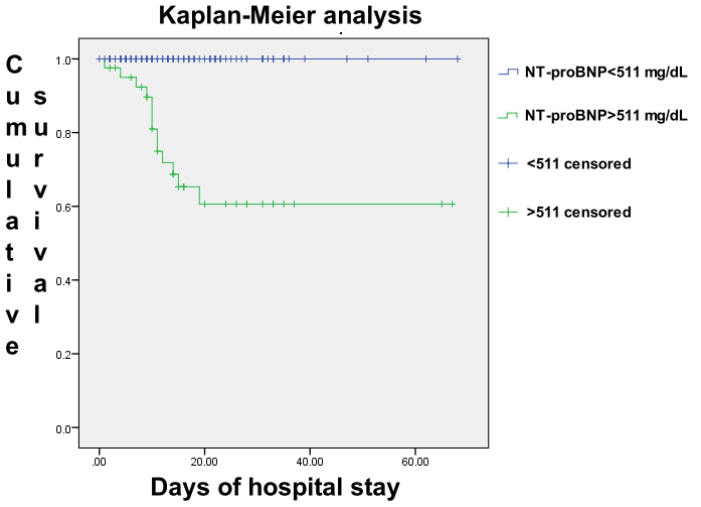
Figure 2. Kaplan–Meier survival analysis between groups with highest value of NT-proBNP ratio higher or lower than 95 during hospital stay. Statistical difference evaluated with log-rank